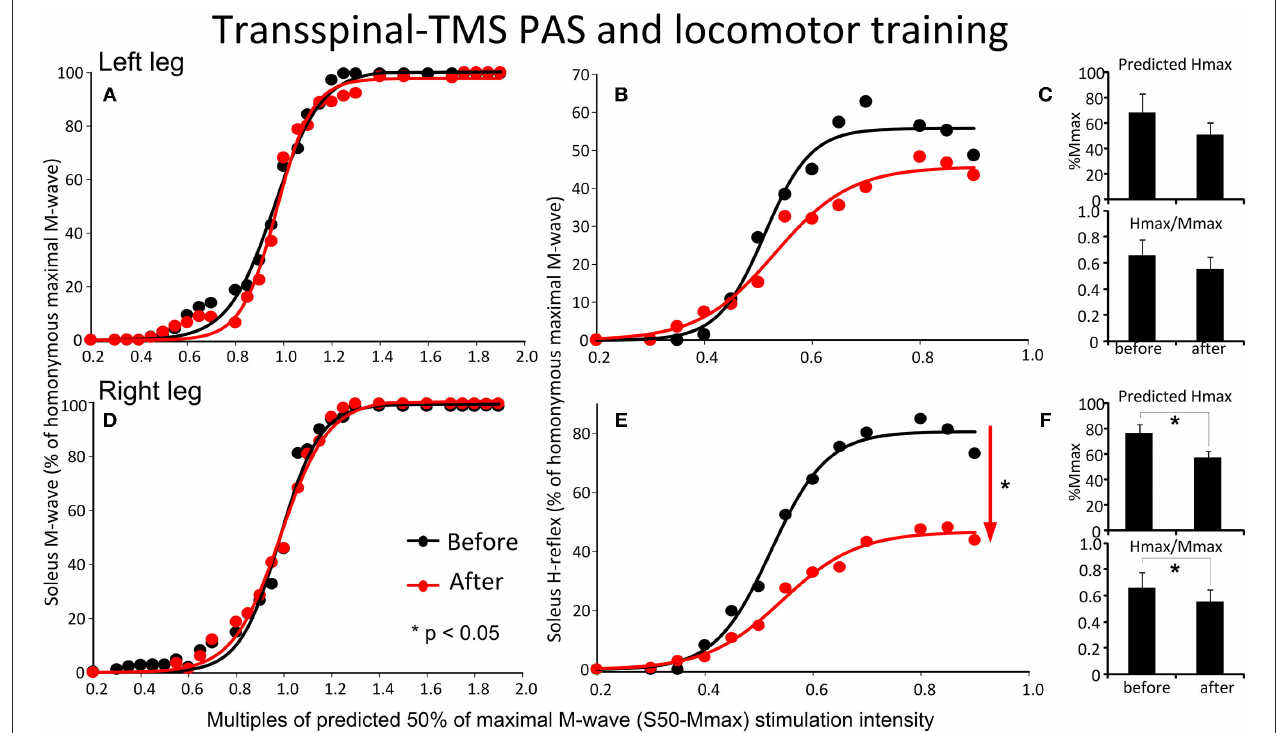
FIGURE 6 | Effects of transspinal-TMS PAS and locomotor training on soleus H-reflex input-output curves. Soleus M-waves and H-reflex recruitment input-output curves recorded at different stimulation intensities from the left (A,D) and right (B,E) legs during standing with body weight support before and after transspinal-TMS PAS and locomotor training. Sigmoid functions are fitted to the input-output curves. (C,F) Corresponding predicted Hmax and Hmax/Mmax for the left (C) and right (F) legs. Hmax, maximal H-reflex; Mmax, maximal M-wave; PAS, paired associative stimulation; TMS, transcranial magnetic stimulation. Error bars indicate the SEM. * p <